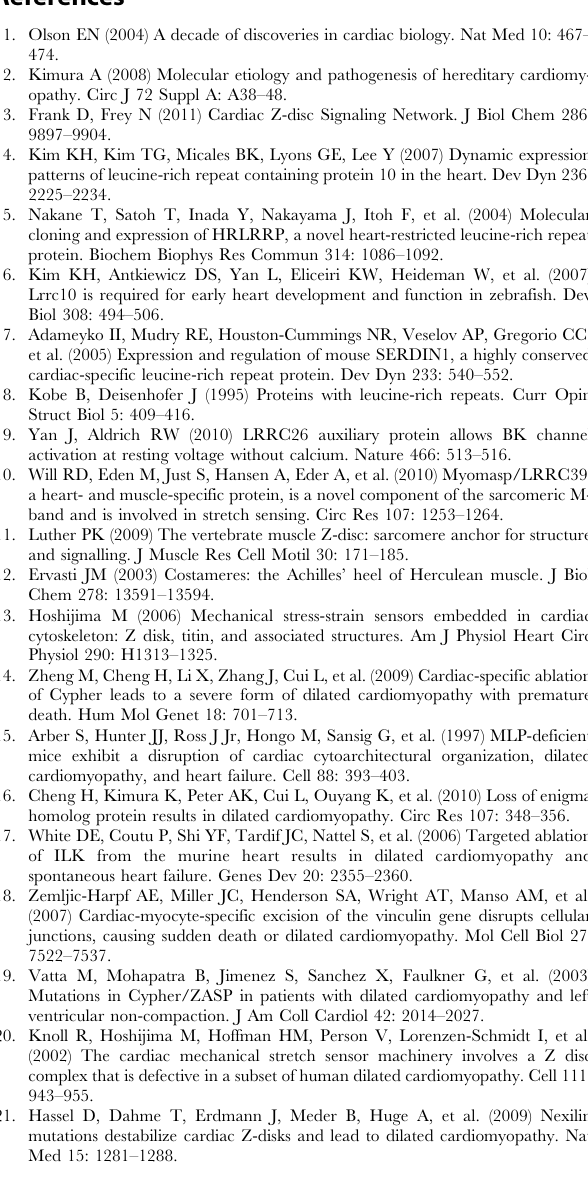
Figure S1 Lrrc10 2 / 2 hearts undergo normal prolifera- tion. Immunostaining for phosphohistone H3 (p-H3) as a mitotic marker in WT and Lrrc10 2 / 2 heart sections showed no alterations in proliferation at E13.5 or one month of age. Figure S2 Myofibril protein expression in Lrrc10 2 / 2 hearts. No significant difference in protein expression